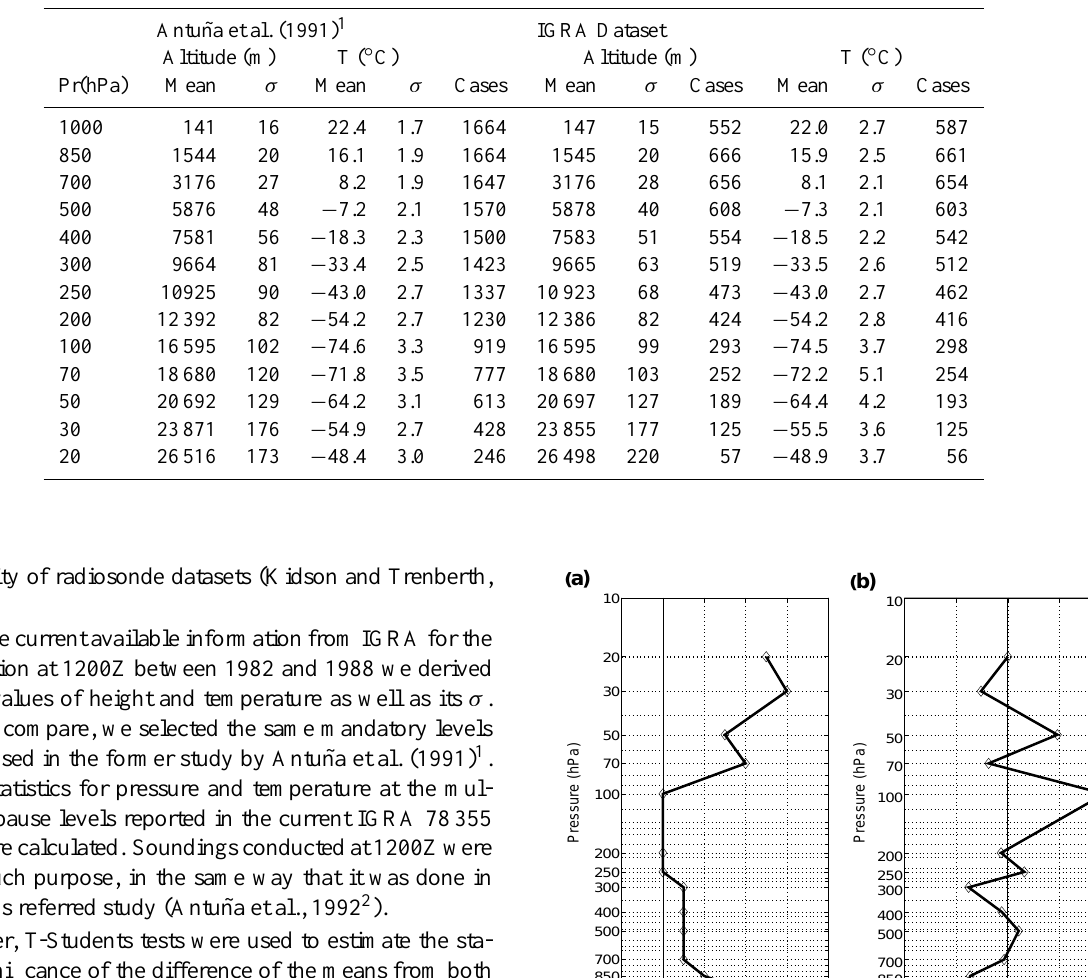
Table 1. Statistics for the height and temperature at selected mandatory levels from reports at Camag¨uey radio-sounding station (WMO number 78355) derived from original handwritten reports and from the current IGRA dataset.